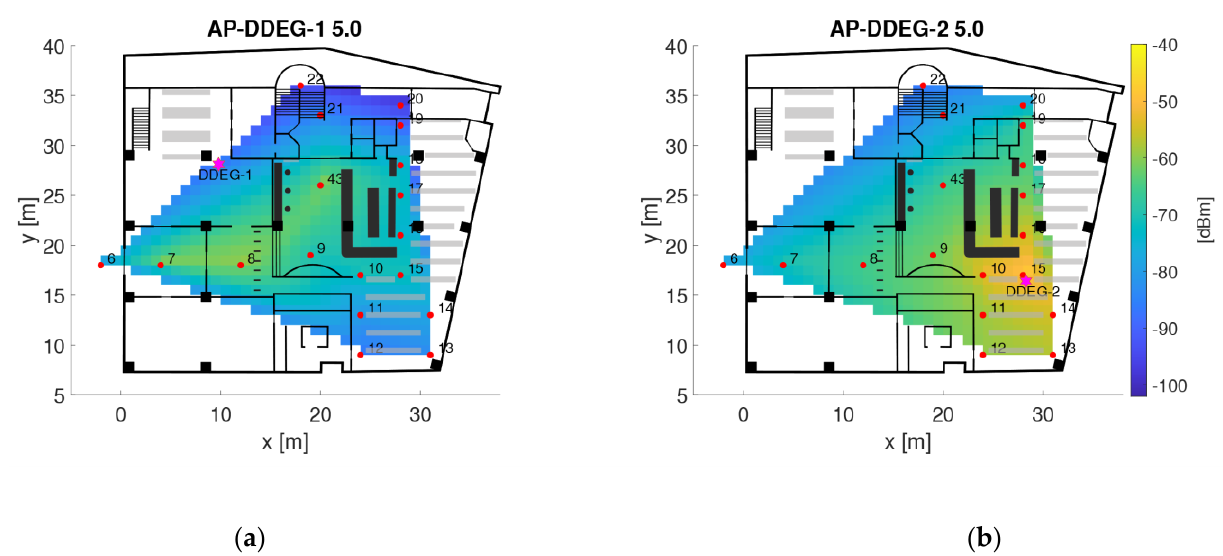
Figure 7. Radio maps for the two APs ( a ) AP-DDEG-1 and ( b ) AP-DDEG-2 on the ground floor of the library.